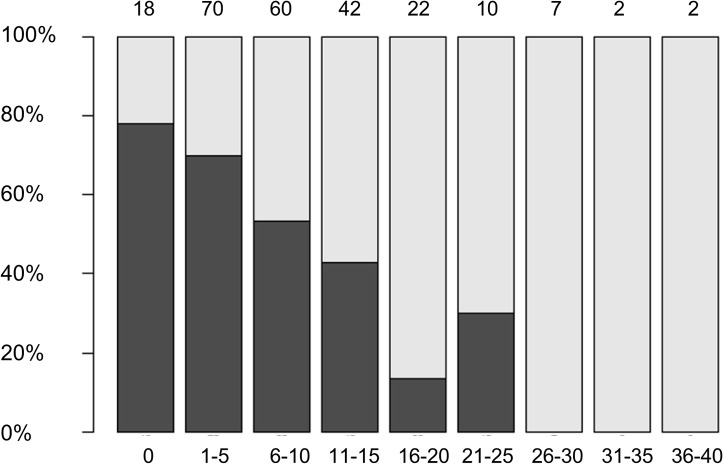
Relative frequency of good (black) and bad (white) sleepers in each group of patients with similar BDI scores.The number of patients is shown above the bars and the range of BDI score for each subgroup is shown below the bars.